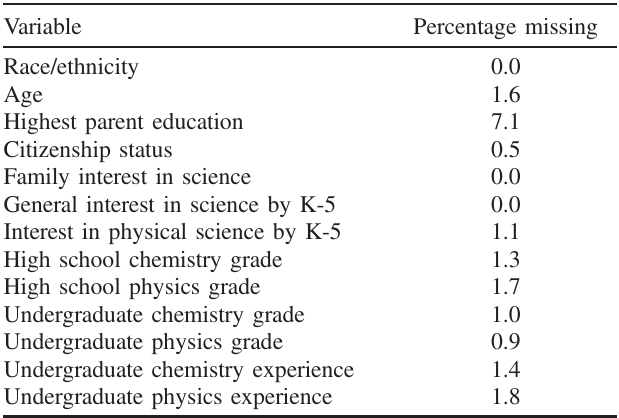
TABLE II. Project Crossover study sample missing-data